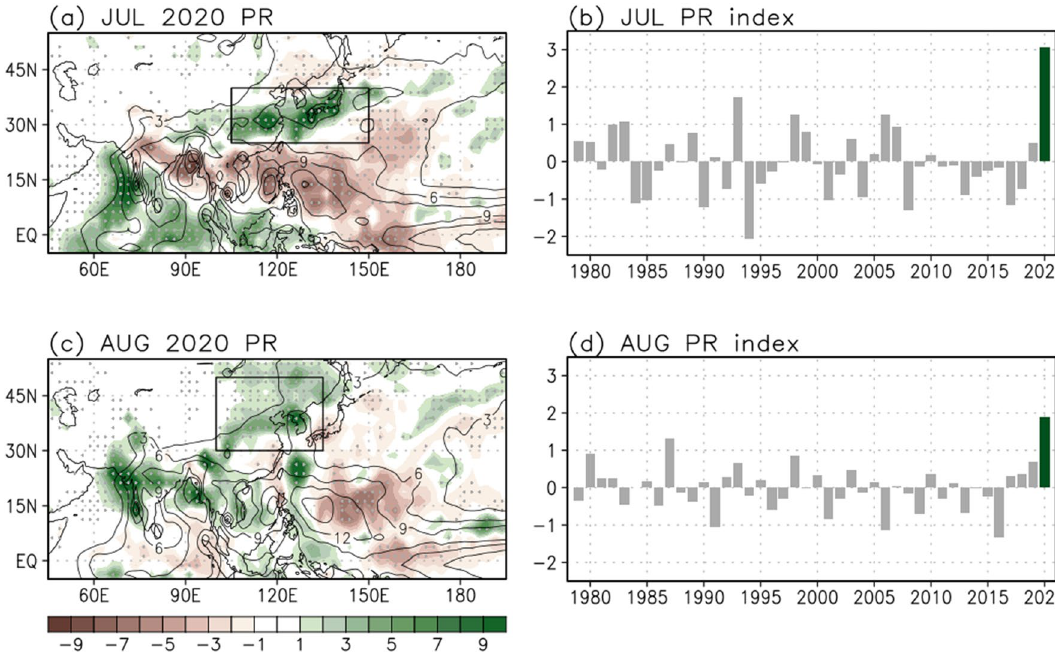
Figure 1. Rainfall climatology (contour; mm/day) in ( a ) July and ( c ) August, and anomalies (shading) in 2020. Values over the 1 standard deviation are stippled. The East Asian regions for July (105°–150° E, 25°–40° N) and August (100°–135° E, 30°–50° N) are indicated by the black-outlined rectangles. Time series of the area- averaged rainfall index in East Asia for ( b ) July and ( d ) August during 1979–2020. The rainfall values of 2020 are in green